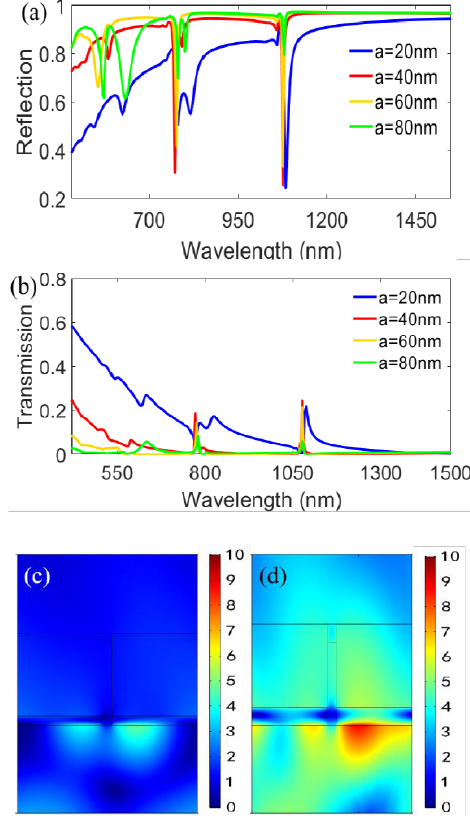
Figure 12. Influences of the metal film thickness with synchronous change for the top and bottom under TM polarized incidence at θ = 10° from the structural bottom. ( a ) The calculated reflection spectra at different Ag film thicknesses; ( b ) The calculated transmission spectra at different Ag film thicknesses; Magnetic field distributions of ( c ) a = 20 nm and ( d ) a = 40 nm for the first reflection dip.